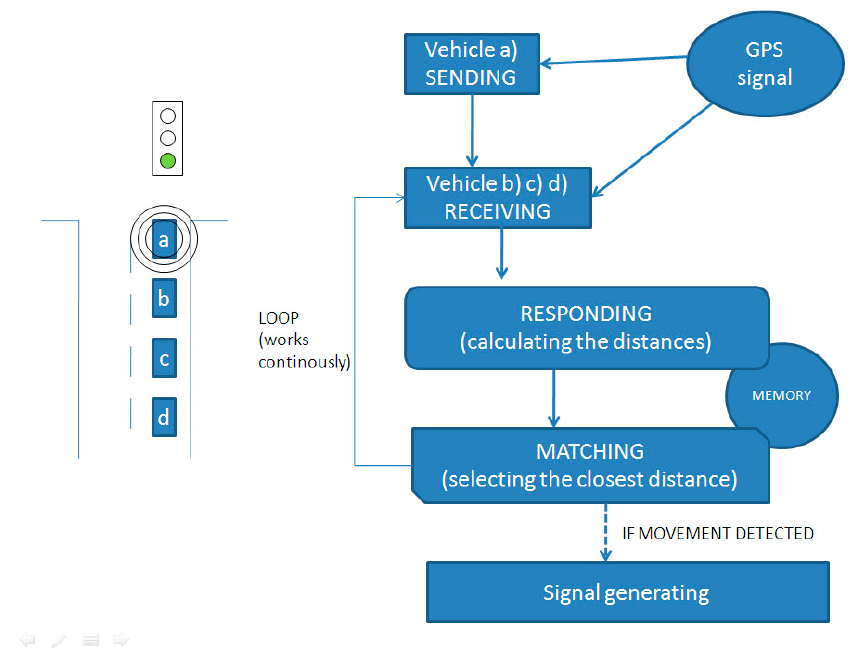
Figure 5. A diagram (visualization) of the described system architecture.